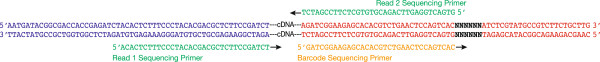
Library and sequencing primer sequences.